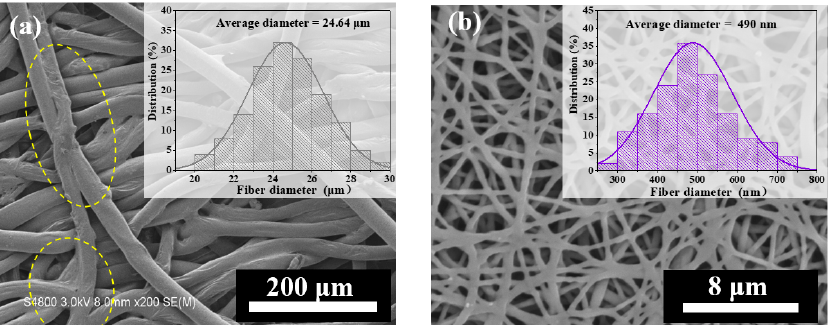
Figure 3. SEM image and diameter distribution of micro-/nano-composite membranes: ( a ) PLA side, ( b ) TPU side. ( b ) TPU side.